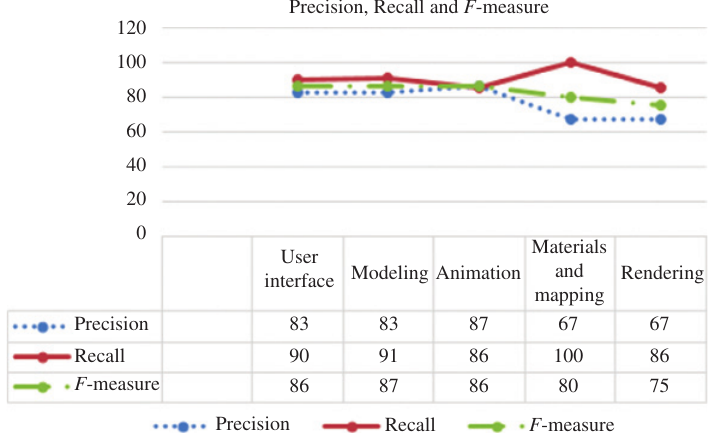
Figure 7. Precision, Recall, and F -Measure.